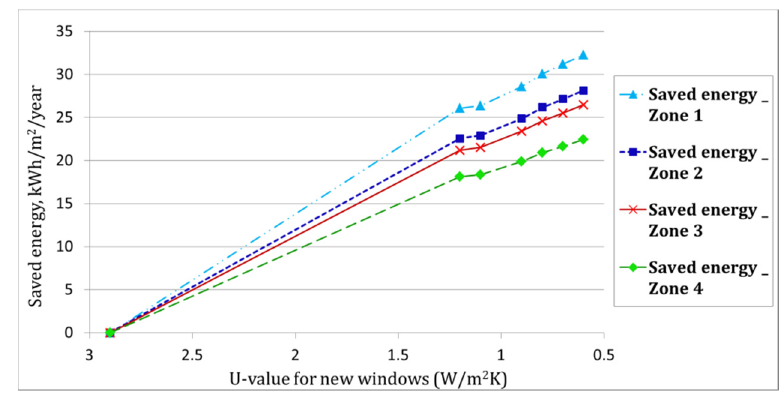
Figure 9. Saved energy for space heat demand due to additional insulation on the exterior walls.